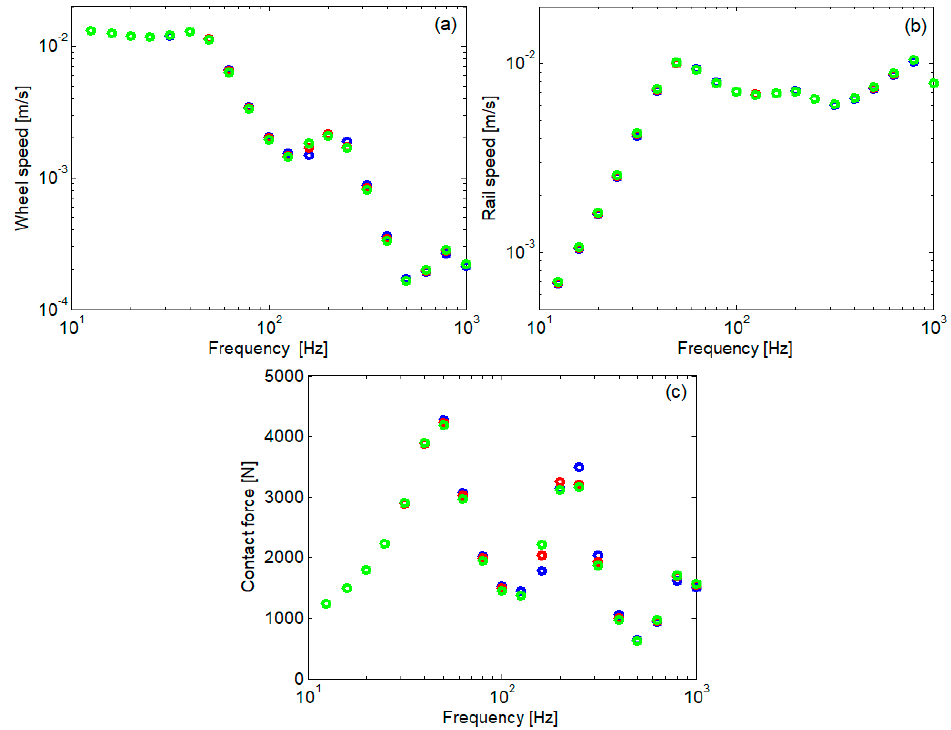
Figure 17. Spectrum of rms value: ( a ) wheel speed; ( b ) rail speed; ( c ) contact force; ᵒ , stiff characteristic, ᵒ , medium characteristic; ᵒ , soft characteristic; color code as in Figure 15.